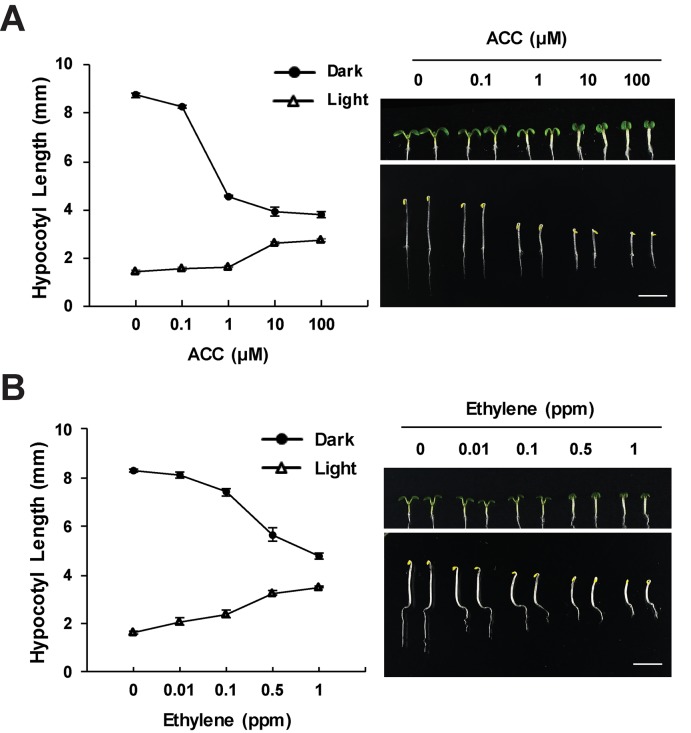
Ethylene and ACC inhibit hypocotyl elongation in the dark and increase elongation in the light. Wild-type seedlings were grown on media containing the indicated concentrations of ACC or on control media and treated with ethylene gas for 3 days in the dark or 5 days in light. The effects of (A) ACC or (B) ethylene on hypocotyl growth in dark and light conditions. Images generated by the Yoon lab (Seo and Yoon, 2019), recapitulating previous findings (Bleecker et al., 1988; Guzman and Ecker, 1990; Smalle et al., 1997; Le et al., 2005; Liang et al., 2012). Values shown are the average and SD of three replicates, each containing at least 20 seedlings.